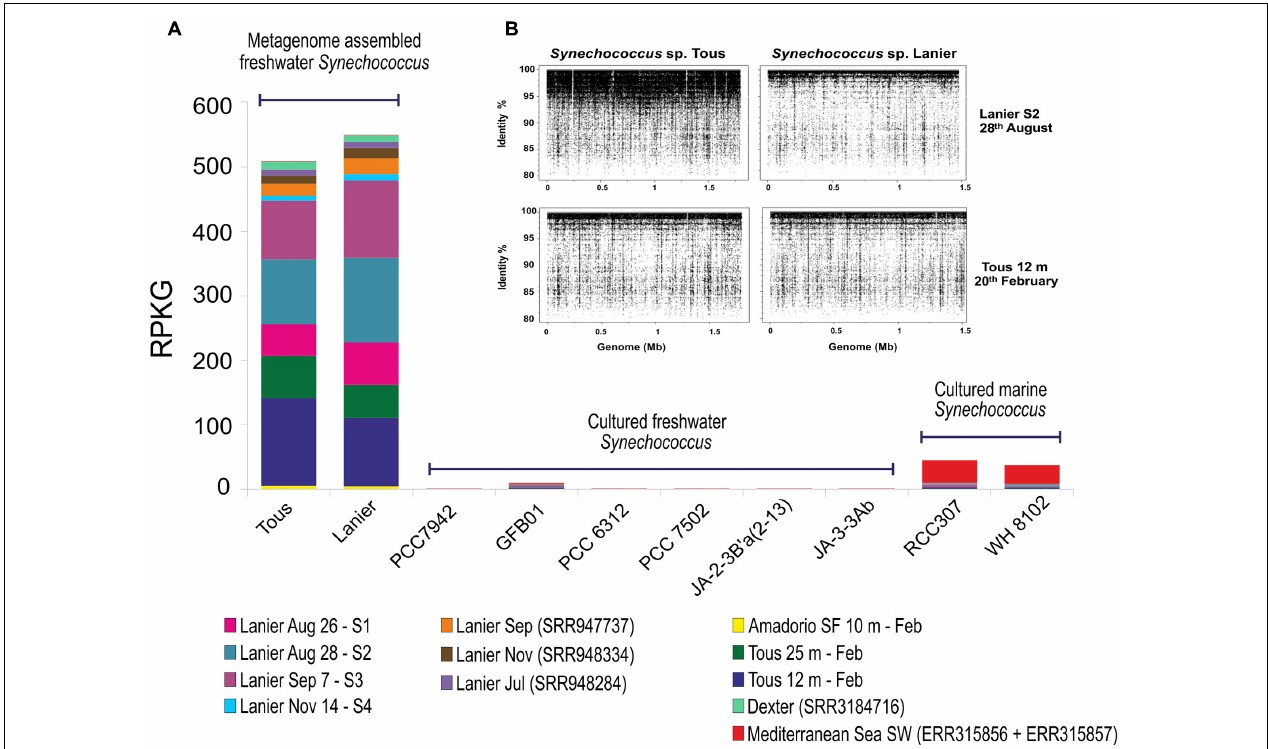
FIGURE 3 | (A) Fragment recruitment of novel and reference Synechococcus sp. Genome abundance (expressed as RPKG, reads per Kb of genome per Gb of metagenome) along different freshwater metagenomes and two marine metagenomes. Only datasets with > 5 RPKG values for the novel freshwater Synechococcus sp. were included in this analysis. Only hits with ≥ 95% identity, ≥ 50 bp alignment length were considered. Sep, September; Nov, November; Feb, February; Jul, July; Aug, August; SF, small fraction. (B) Metagenomic recruitment of Synechococcus sp. Tous and Lanier assembled genomes against Lanier S2 sample (5 m August 28th, 2011) (I) and Tous 12 m February 2014 (II) metagenomes. A 95% identity cut-off and 50 bp read length on each metagenome were used as restrictive